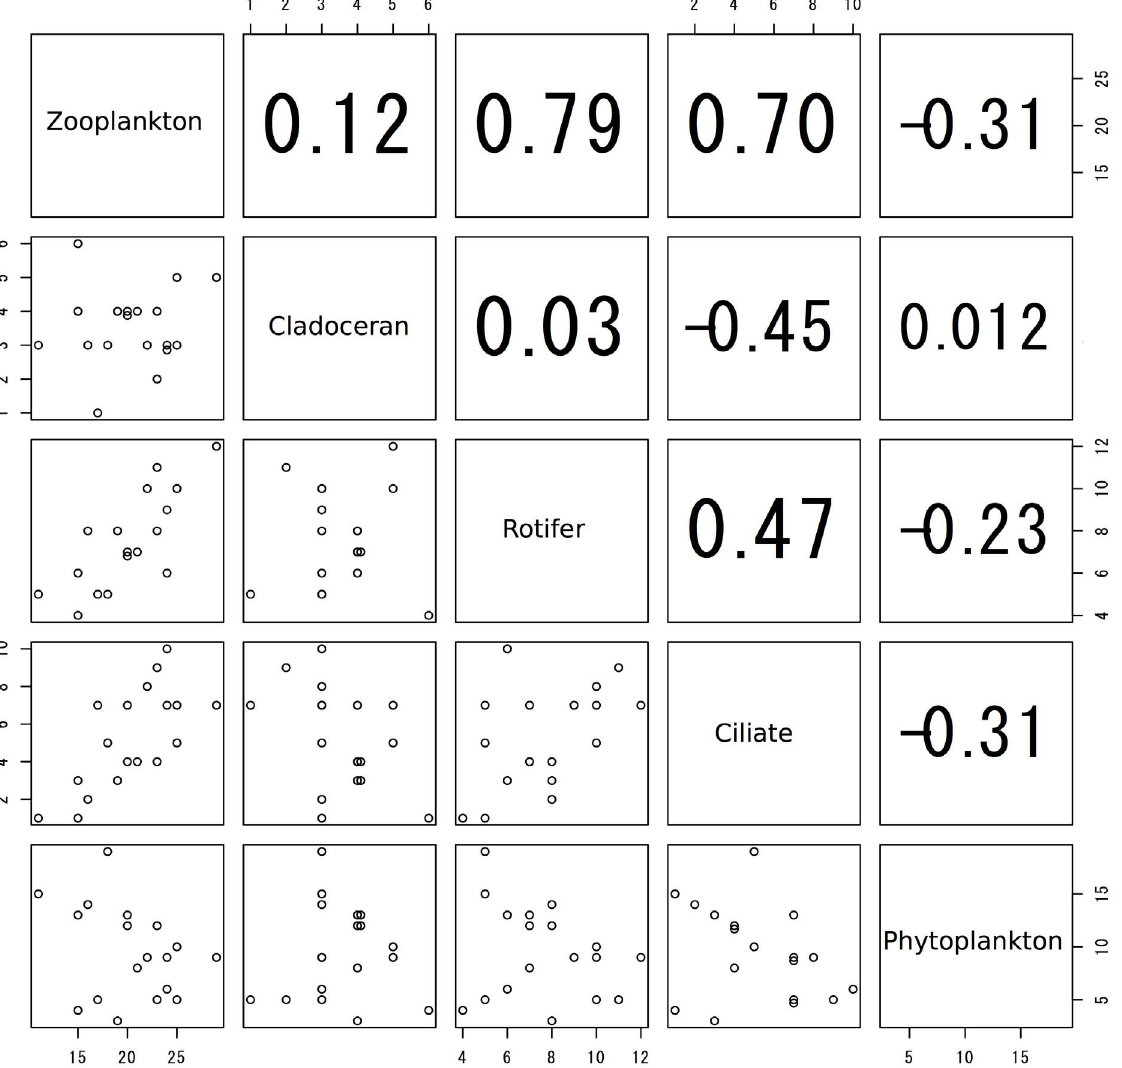
Figure 1. Pair plot for genus richness of plankton taxonomic groups and whole zooplankton. The pair plots showing genus richness of the plankton taxonomic groups, namely, cladocerans, rotifers, ciliates, and phytoplankton, and whole zooplankton. Each point represents a single pond ( n =18). The numbers in the upper right-hand columns denote Pearson’s correlation coefficients.